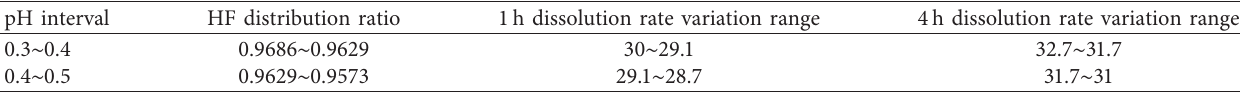
Table 4: The relationship between the proportion of HF in different pH values and the range of dissolution rate at different times. pH